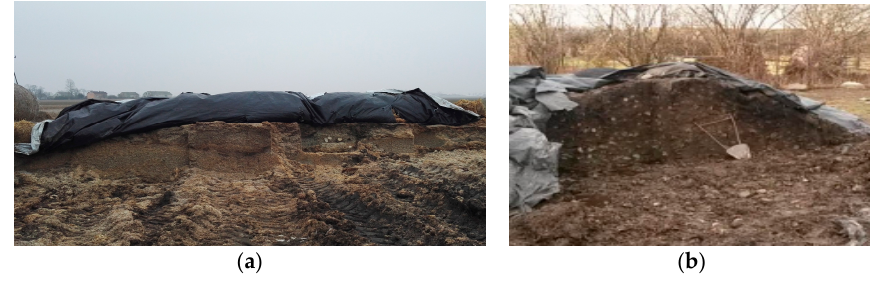
Figure 9. Traditional method of silage in prisms of: ( a ) beet pulp; and ( b ) beet leaves. Table 8. Specific surface area and textural properties of the studied supports.